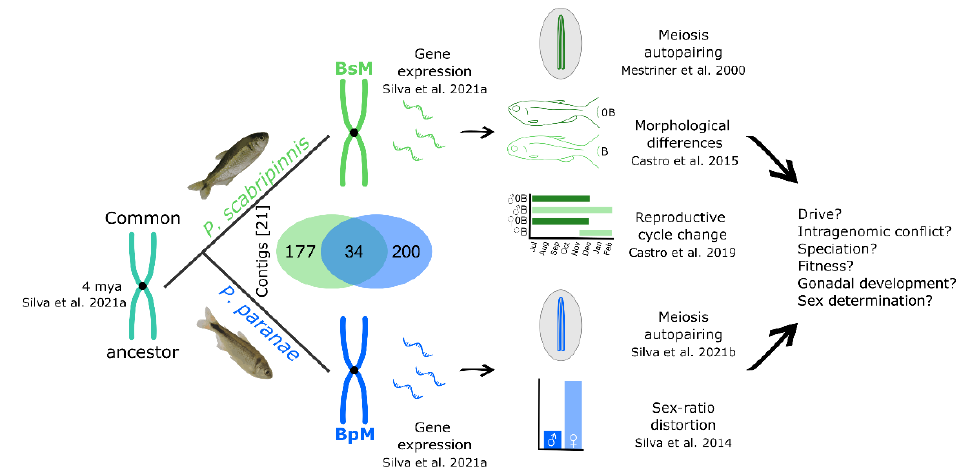
Figure 2. Origin, evolution, and effects of Psalidodon scabripinnis complex metacentric B chromo- somes. Numbers in square brackets refer to references. On the right, features involving the B chro-